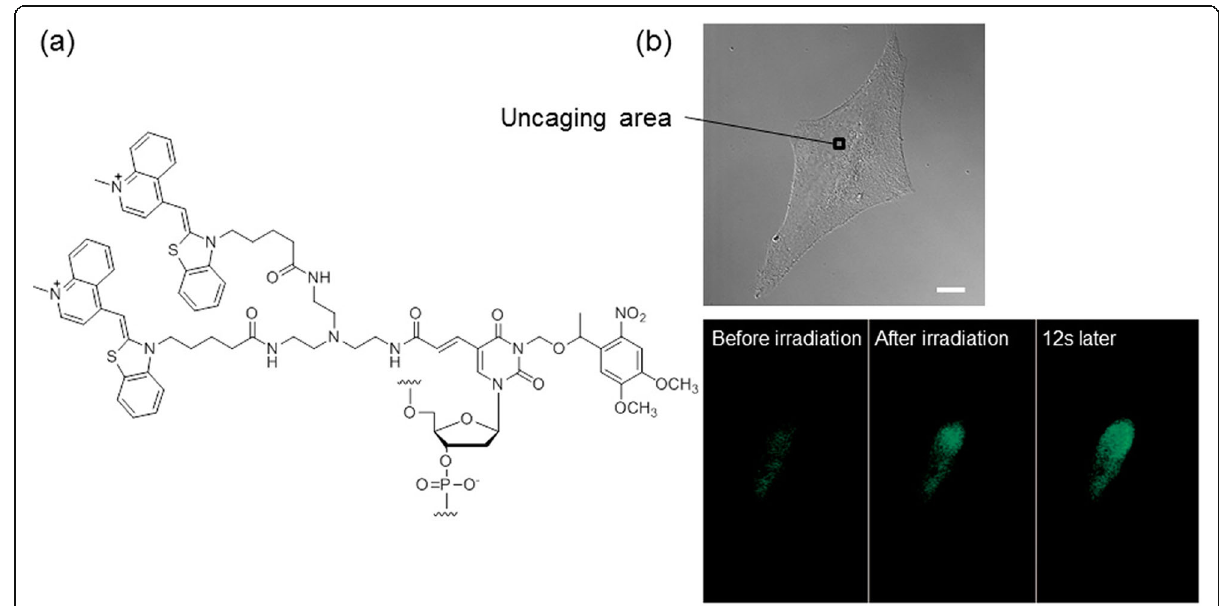
Fig. 3 Pinpoint activation of caged ECHO probe. a Chemical structure; b Diffusion of the fluorescence after uncaging at an irradiation area (square) in the nucleus of the cell into which a caged ECHO probe was injected. Bar: 10 μ m